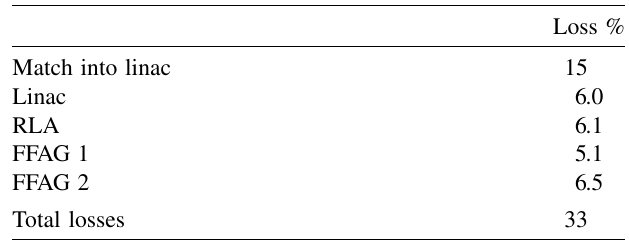
TABLE X. Particle losses from cooling to storage